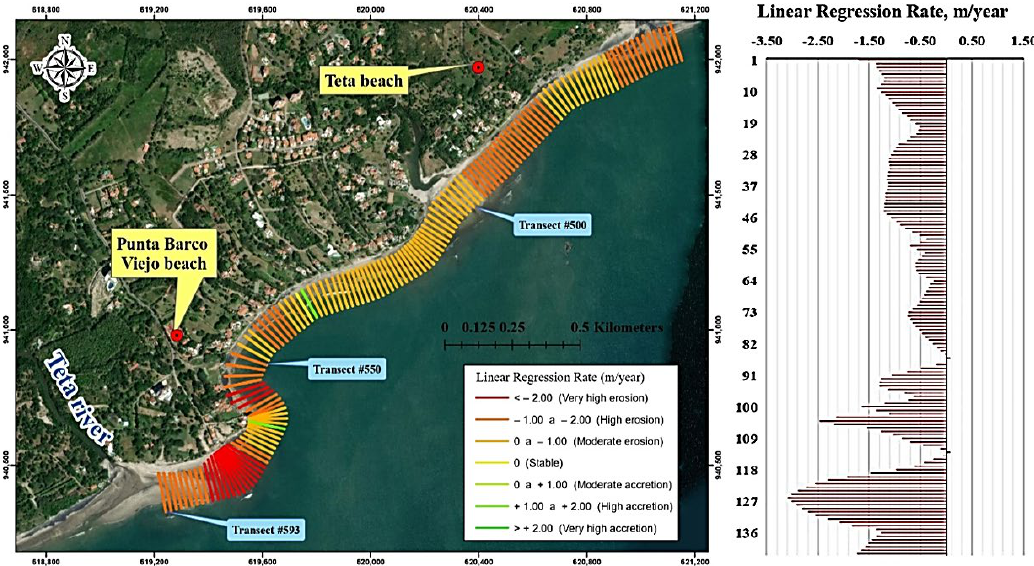
Figure 9. Erosion or accretion degrees and profiles obtained by analyzing zone III by applying the Linear Regression Rate (LRR) for the period from 1998 to 2021.